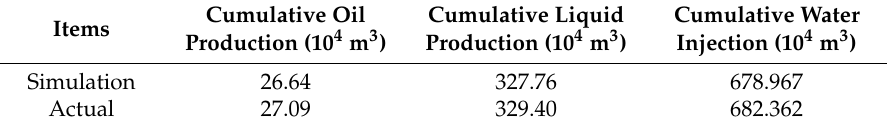
Table 1. Production dynamics of the whole block.